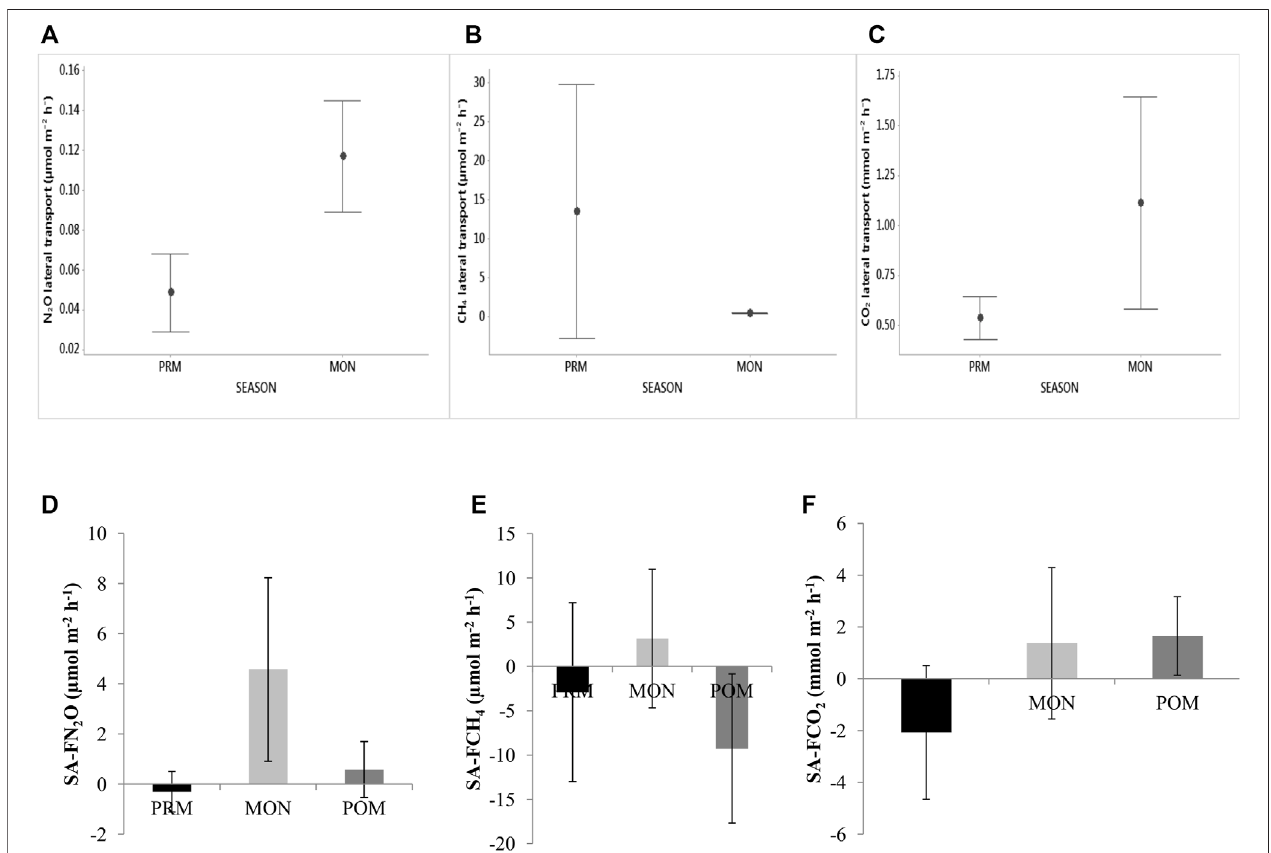
FIGURE5| Comparison betweenintertidal sediment/water transportofRAGsand sediment/air RAGemissionbyseasons.Error bars indicate standard deviation.